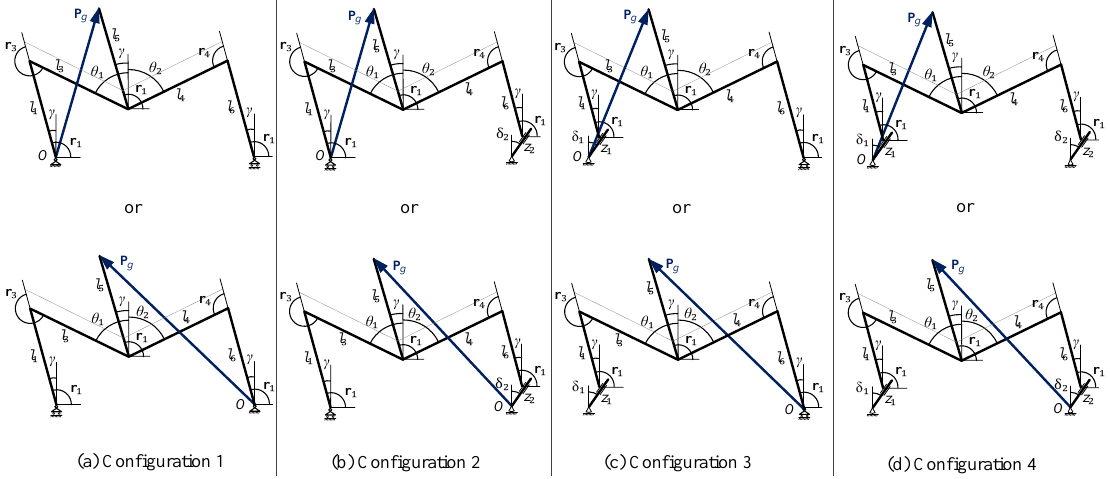
Figure 12. Definition of the generalized coordinate variables for each of the configurations of the